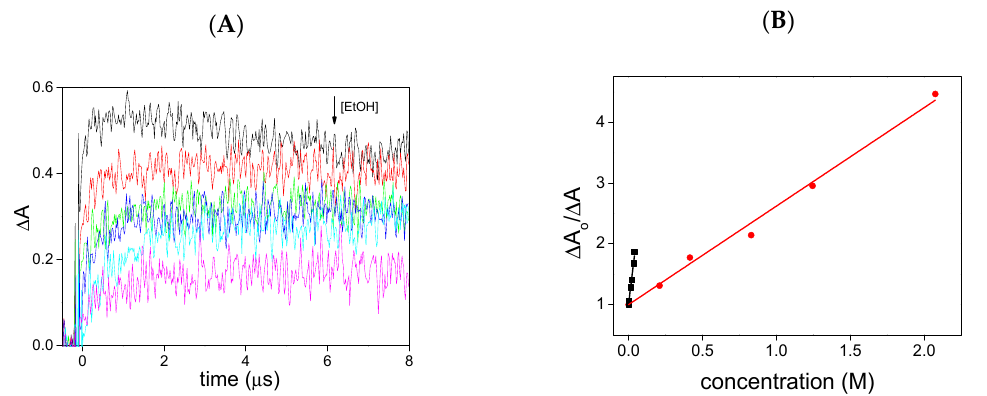
Figure 1. ( A ) Kinetic traces recorded at 390 nm after laser flash photolysis irradiation ( λ exc = 355 nm) of deaerated acetonitrile solutions of N -hydroxypyridine-2(1H)-thione (NPT) (0.29 mM) and trans -stilbene (TS) (7.5 mM) with increasing concentrations of ethanol (0–2.075 M); ( B ) Corresponding Stern–Volmer plots obtained as the ratio ∆ A o / ∆ A x versus C x for Naph (0–0.05 M, black squares) and ethanol (0–2.075 M, red circles). (The values used in the case of Naph were taken from the graph of Scheme 1 bottom).